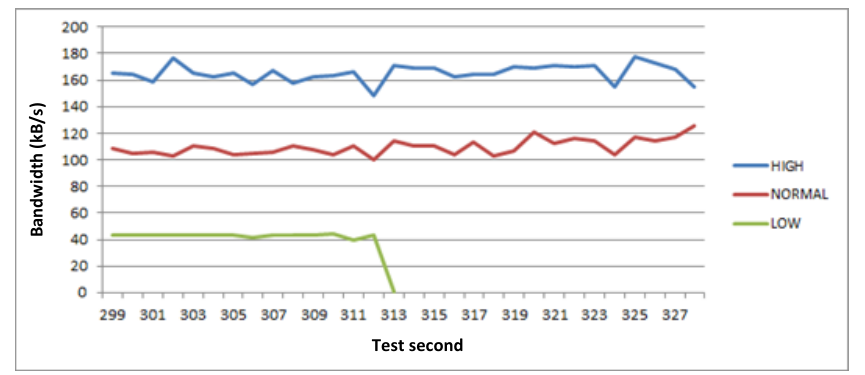
Figure 7. Low priority communication pause for bandwidth limitations.